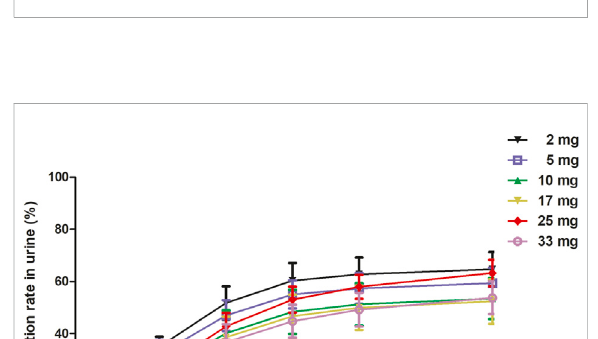
FIGURE 2 Mean plasma concentrations versus time pro fi les following a single dose of WXFL10203614 (2 – 33 mg) in healthy Chinese subjects on linear (A) and semilogarithmic scales (B) .